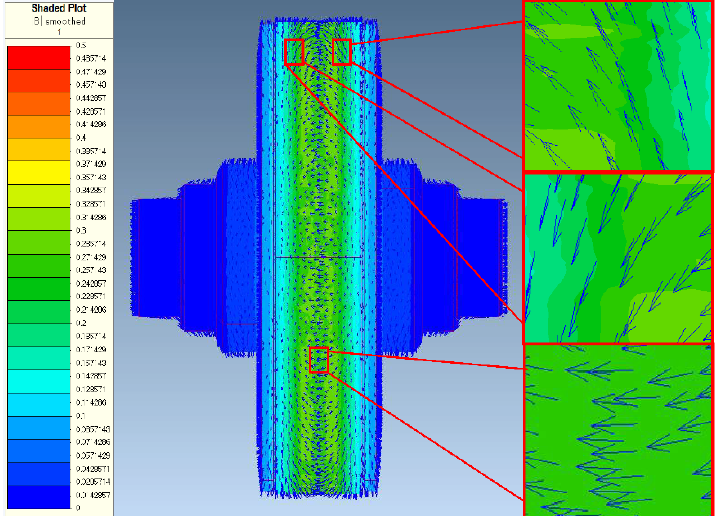
Figure 7. Simulation result of magnetic field vector direction.